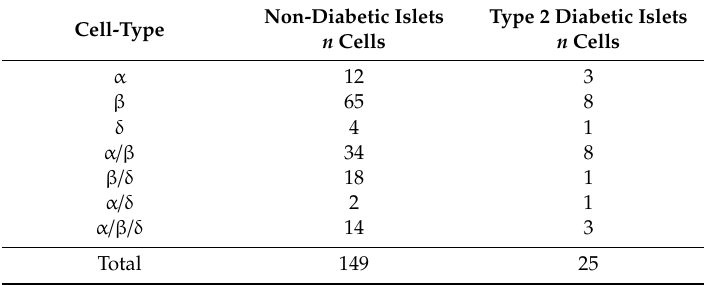
Table 1. Cell-types identified based on expression of hormone mRNAs in pancreatic islets from non-diabetic and type 2 diabetic